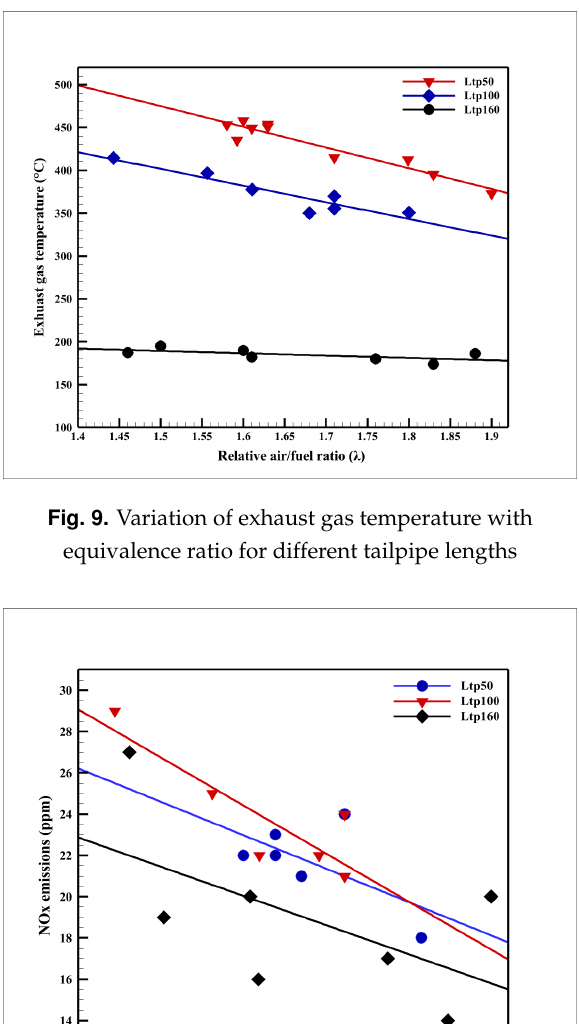
Fig. 11 represents the variation in NO x concentrations with air fuel equivalency ratio for two different combustion chamber volumes, V1 and V2, by using a constant propane flow rate and running under the same operating